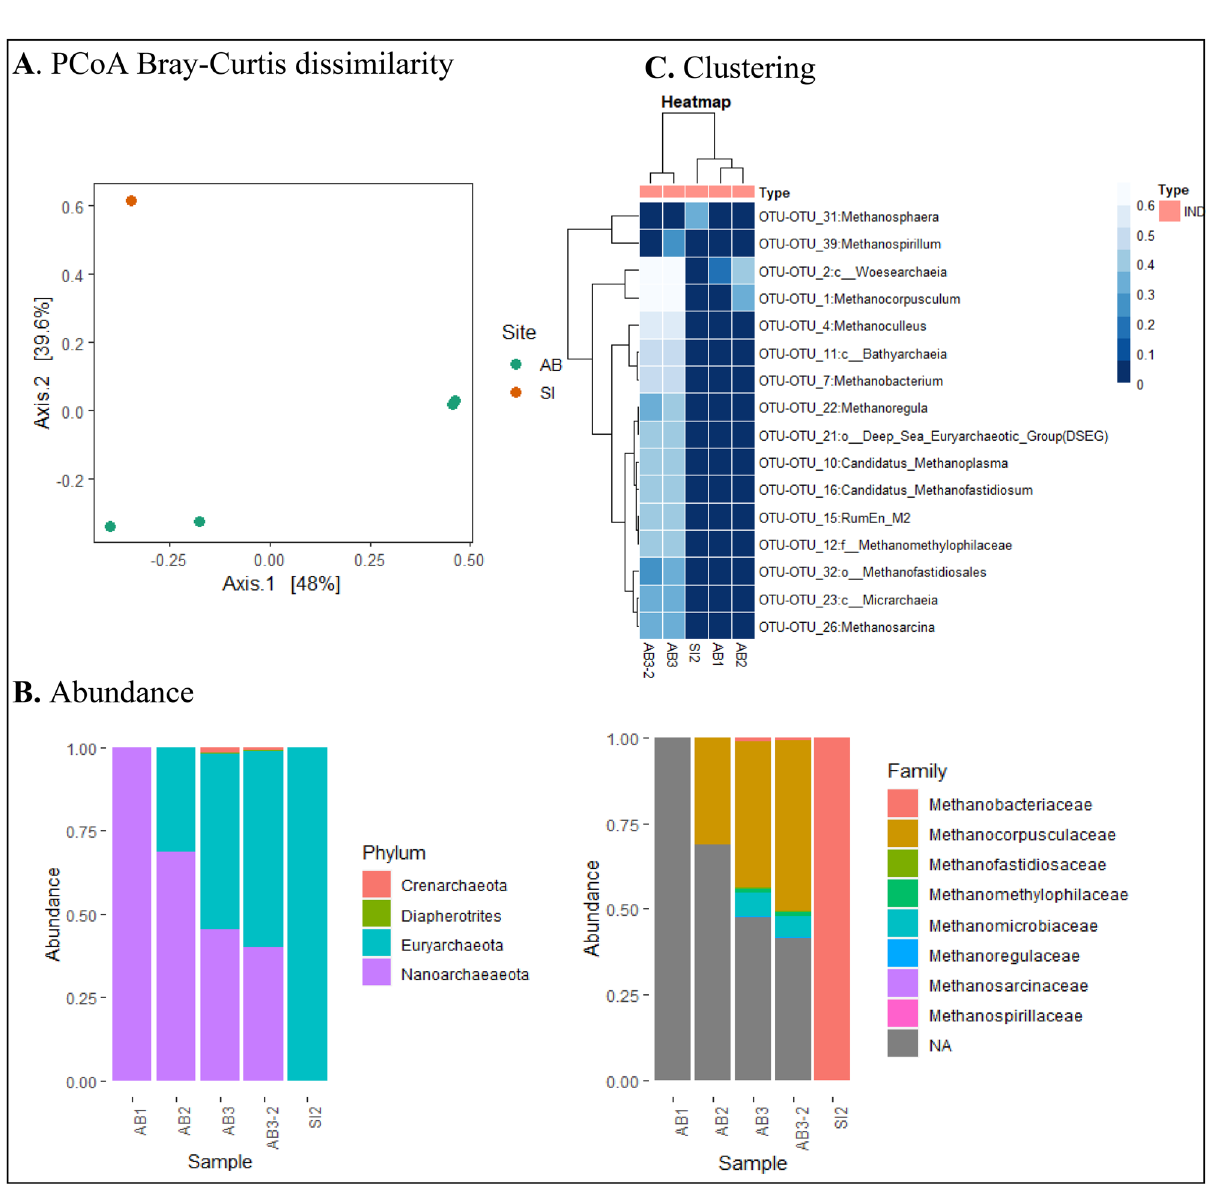
Figure 4. The overall Archaea community structure, relative abundance and clustering of palm oil mill effluents (POME) from Côte d’Ivoire. ( A ) PCoA using Bray–Curtis dissimilarity based on the genus-level ASV shows significant differences between samples (q = 0.014, F = 0.009, PERMANOVA). ( B ) Relative abundance (%) of predominant bacteria at phylum level. ( C ) The hierarchically heat map clustered with top 20 archaea genera between the positive samples. The abundance difference is shown as a color key with a blue colour gradient. The ASV relative abundance data were normalized [log10 (xi + 1)-transformed] before generating the heat map